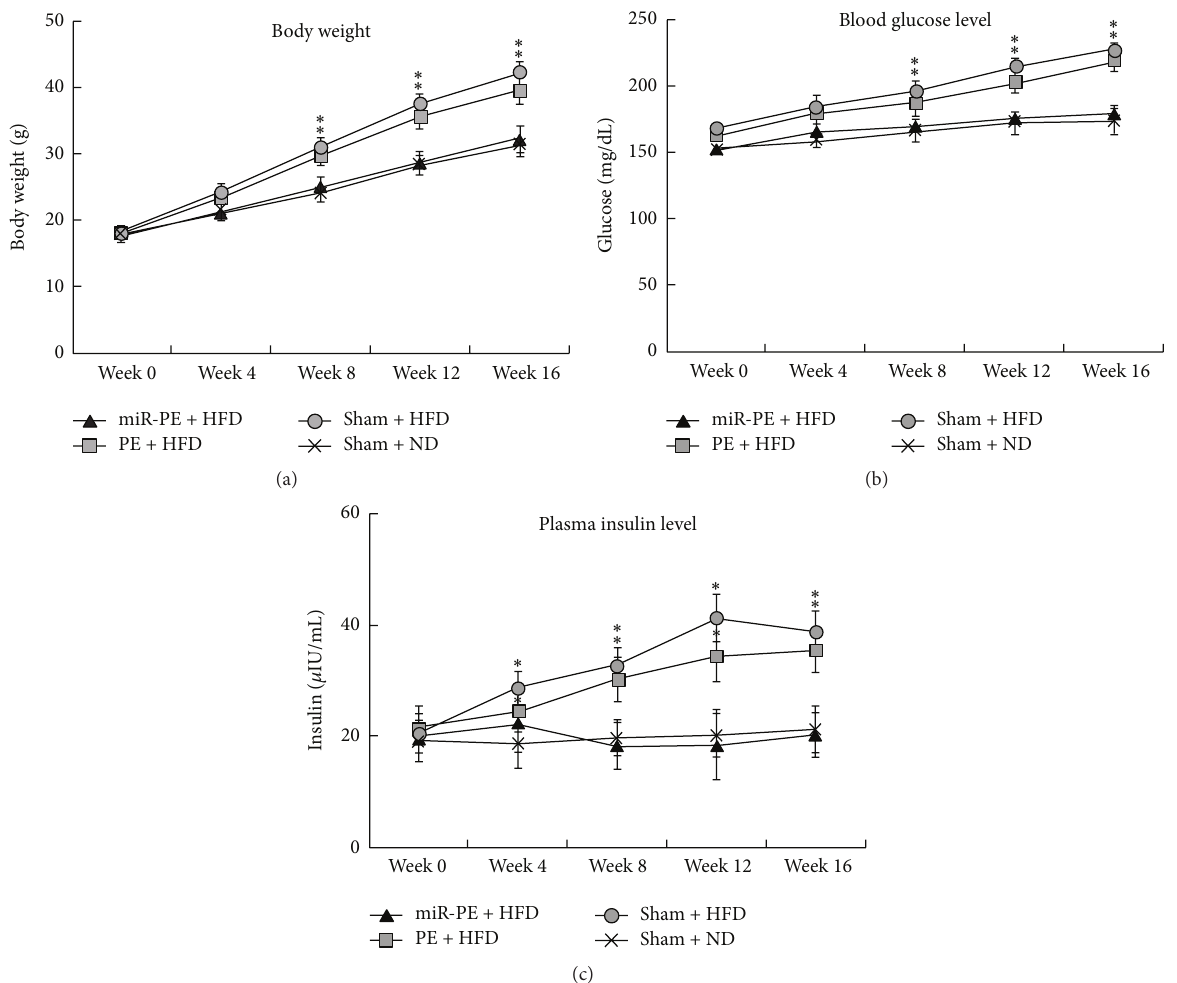
Figure 3: miR-PE transplant alleviated diabetes symptoms in mice. (a) Effect of HFD on body weight of mice. Body weight was measured 1 week after PE transplant for 16 weeks. (b) Blood glucose levels of mice. Blood glucose levels were monitored 1 week after PE transplant for 16 weeks. (c) Plasma insulin levels of mice. Plasma insulin concentrations were measured by ELISA 1 week after PE transplant for 16 weeks. All values are given as mean; error bar represents standard error. ∗ 𝑝 < 0.05 , compared with Sham + ND